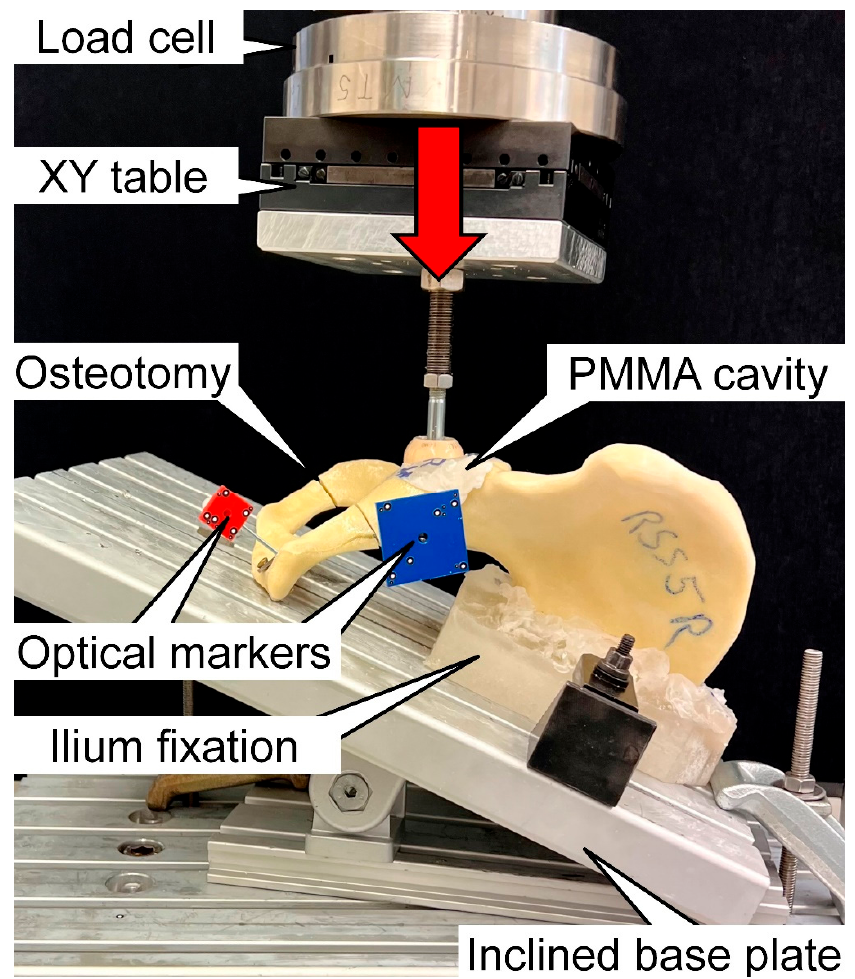
Figure 5. Setup with a specimen mounted for biomechanical testing and a vertical arrow denoting the loading direction.